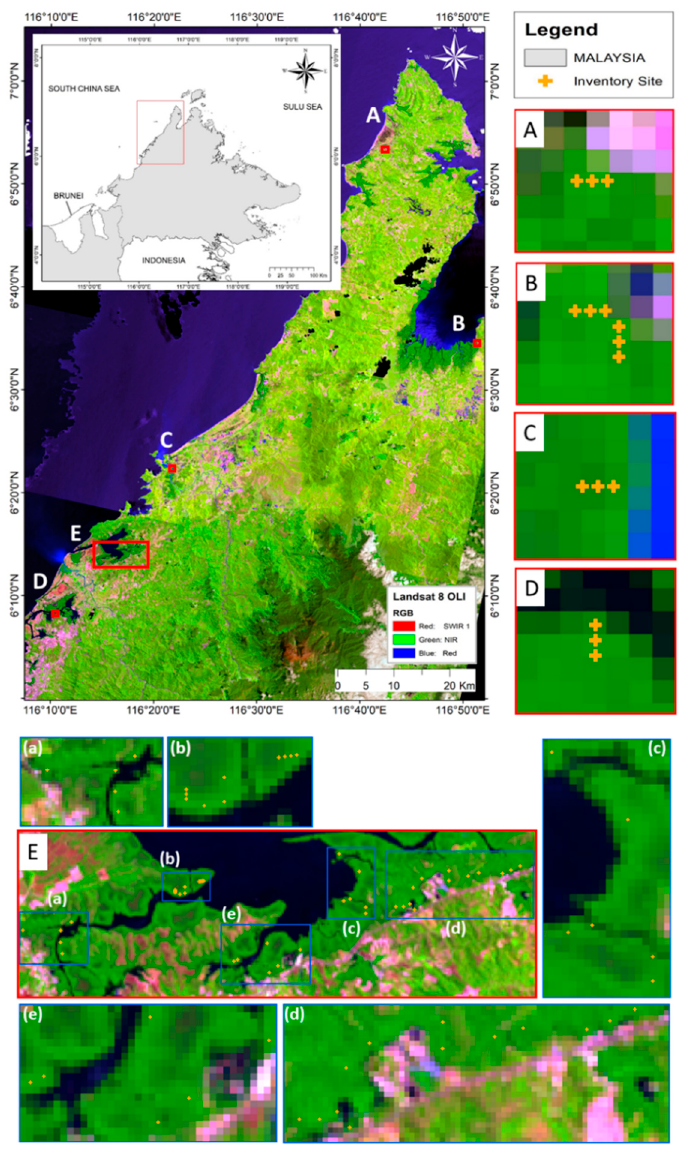
Figure 1. Location of the study area (top part). Field plot locations are plotted as cross (+) in yellow on a Landsat7 image of 2015.